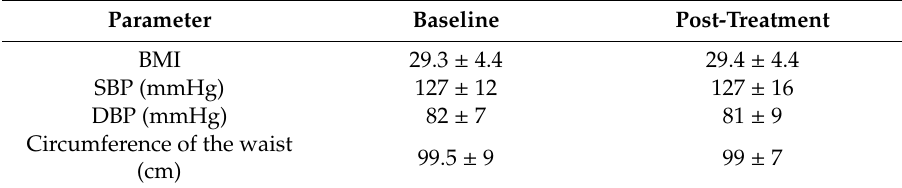
Table 1. Anthropometric characteristics before and after